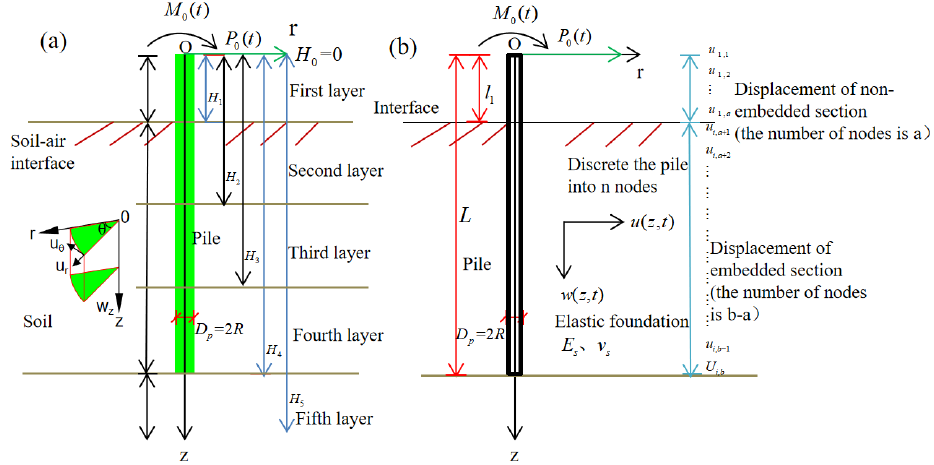
Figure 1. Schematic diagram of the partially-embedded single pile in layered soil: ( a ) Laterally-loaded single pile; ( b ) Analytical model of pile–soil system.